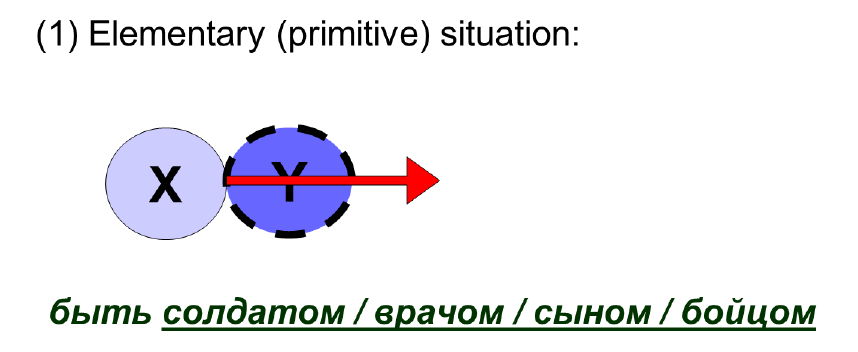
Figure 4 - The situation (1) which the instrumental case can reflect DOI: